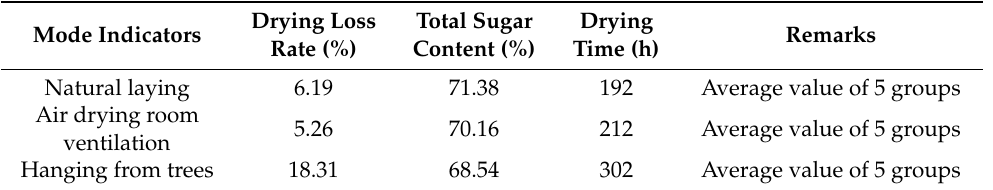
Table 2. Quality change results under different drying